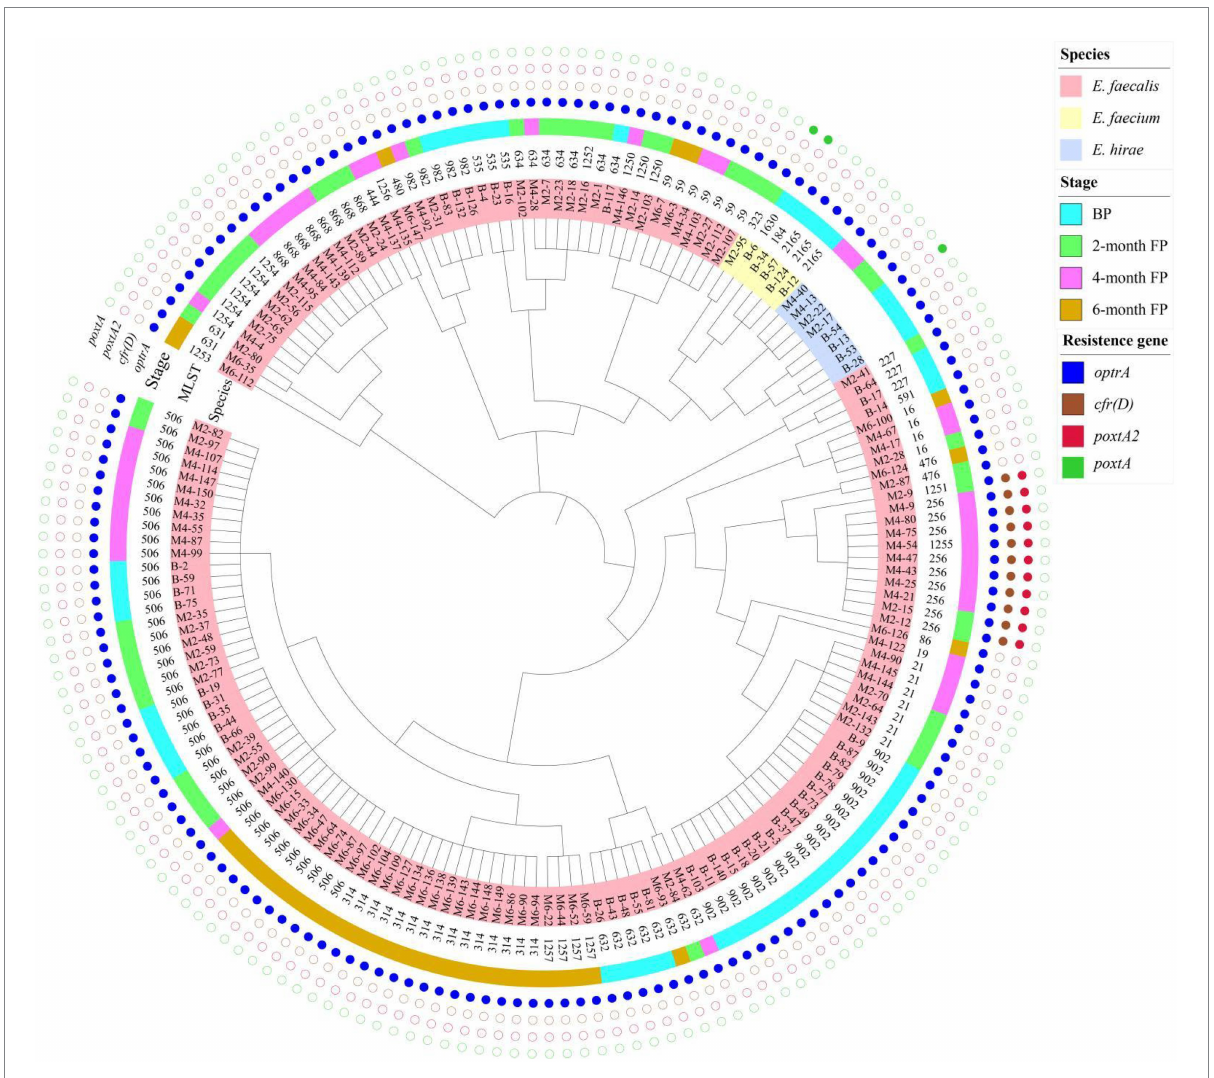
FIGURE 2 Phylogenetic tree based on SNPs of the core genome for 175 enterococcal isolates that harbored different oxazolidinone resistance genes. The species, stage, and oxazolidinone resistance genes are indicated by different